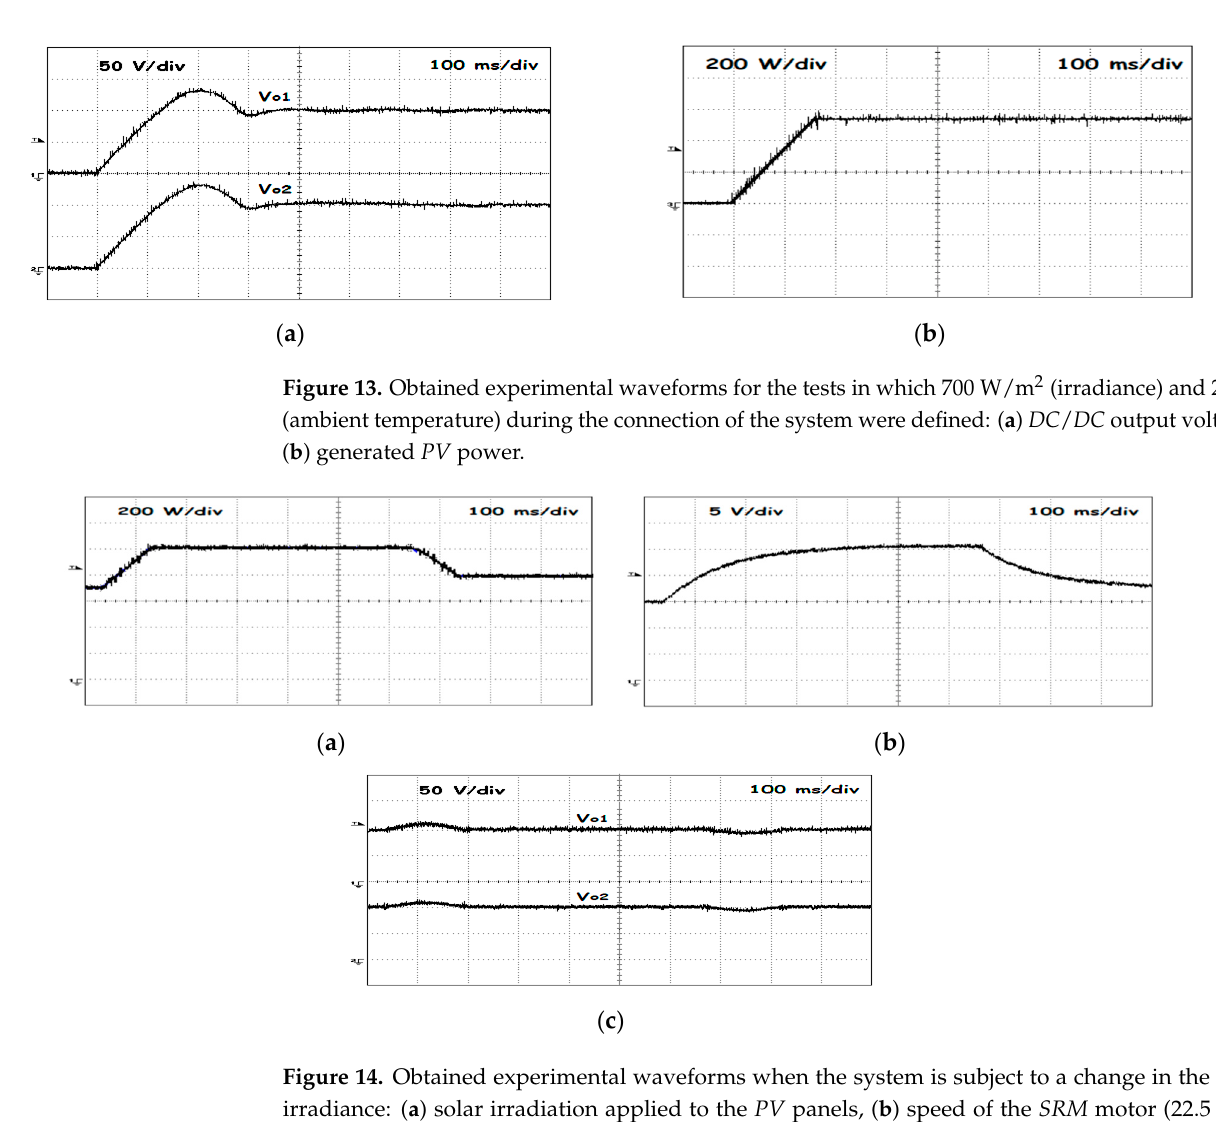
( d ) Figure 12. Obtained experimental waveforms for the tests in which 700 W/m 2 (irradiance) and 25 °C (ambient temperature) associated with the motor drive were defined: ( a ) voltage applied to motor winding A , ( b ) currents in all motor windings, ( c ) input DC voltages applied to the drive, ( d ) converter input current. Similar to the simulation tests, experimental transient tests were also performed. The